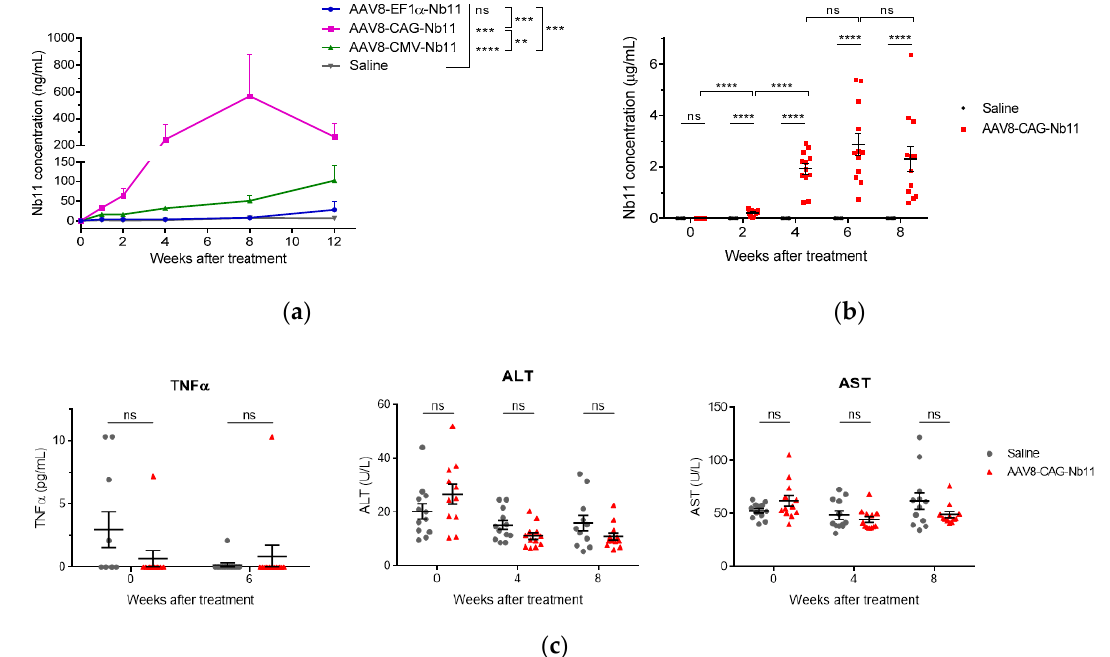
Figure 6. Analysis of Nb11 expression and toxicity in mice treated with AAV vectors. C57BL/6 mice received one dose of the indicated AAV-Nb11 vectors systemically (10 11 vg/mouse), and expression of Nb11 was analyzed over time by measuring its levels in serum with a hPD-1 binding ELISA. ( a ) Serum levels of Nb11 in mice that received AAV8 particles coding for Nb11 under different promoters ( n = 3). Data represent mean + SEM. ( b ) Serum levels of Nb11 in mice treated with AAV-CAG-C11 or saline ( n = 12). ( c ) Serum levels of TNF α , AST, and ALT in mice treated with AAV-CAG-C11 or saline. Data represent mean ± SEM. ** p < 0.01, *** p < 0.001, **** p < 0.0001; ns: not significant.